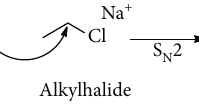
Scheme 3: Williamson ’ s etheri fi